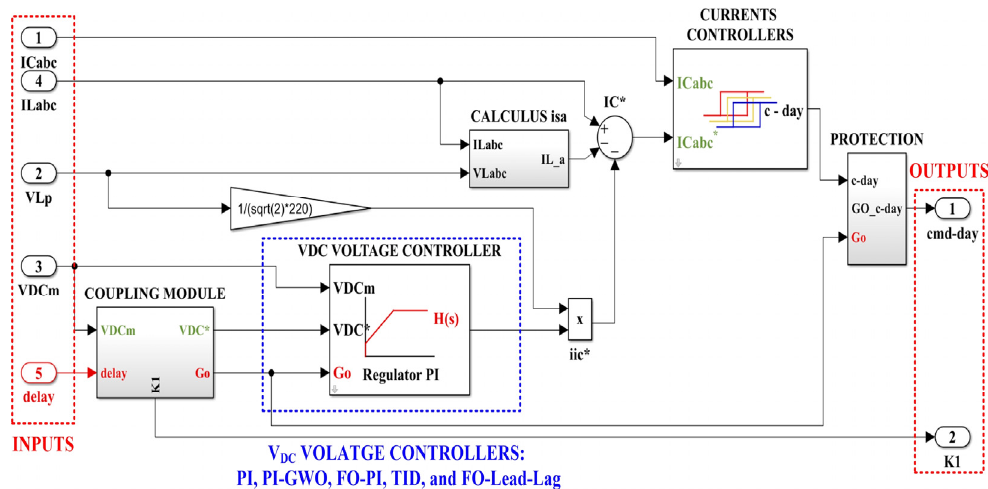
Figure 5. Block diagram subsystem implementation in MATLAB/Simulink of the APF control system based on PI, PI-GWO, FO-PI, TID, and FO-Lead-Lag controllers.